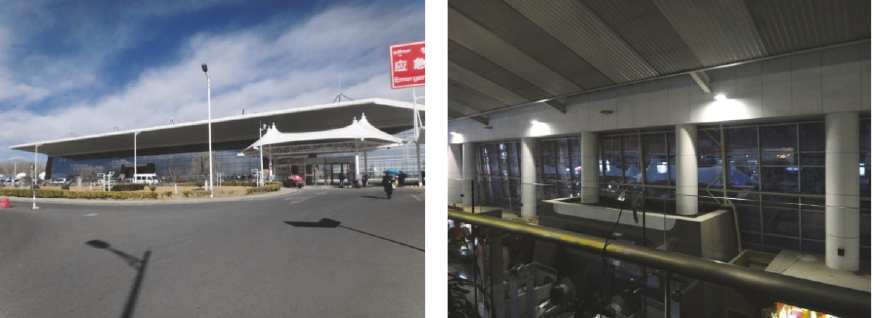
Figure 2: Lhasa Gonggar